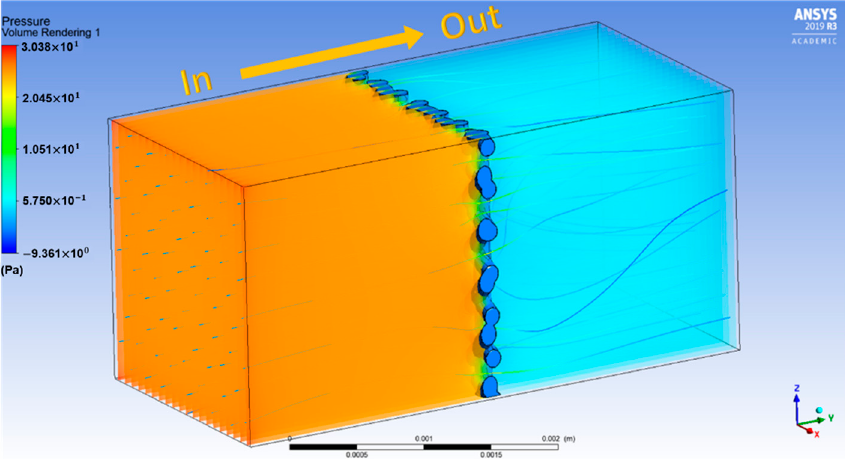
Figure 5. Schematic view of flow field in simulation showing the pressure drop (left: gas inlet and right: gas outlet).